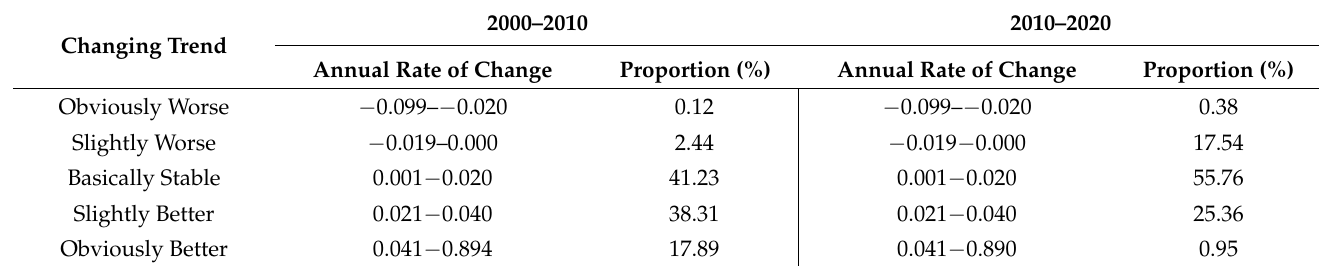
Table 3. Annual growth rate and corresponding area of carbon